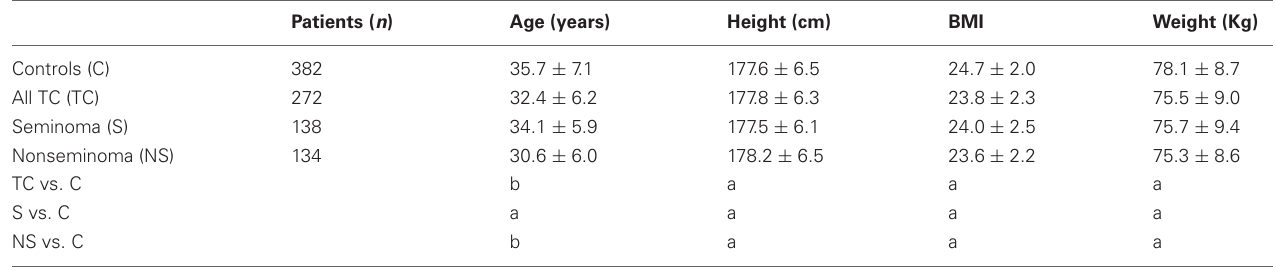
Table 1 | Descriptive statistical analysis of anthropometric measures (Mean ±